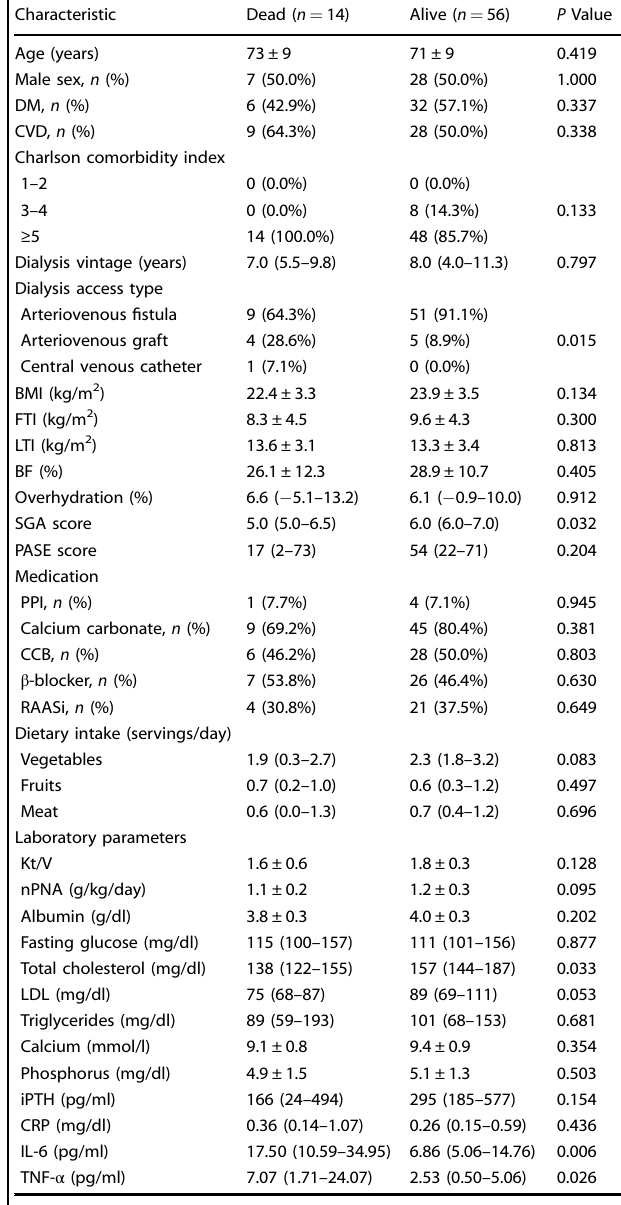
Table 4. Baseline characteristics of patients according to mortality status after